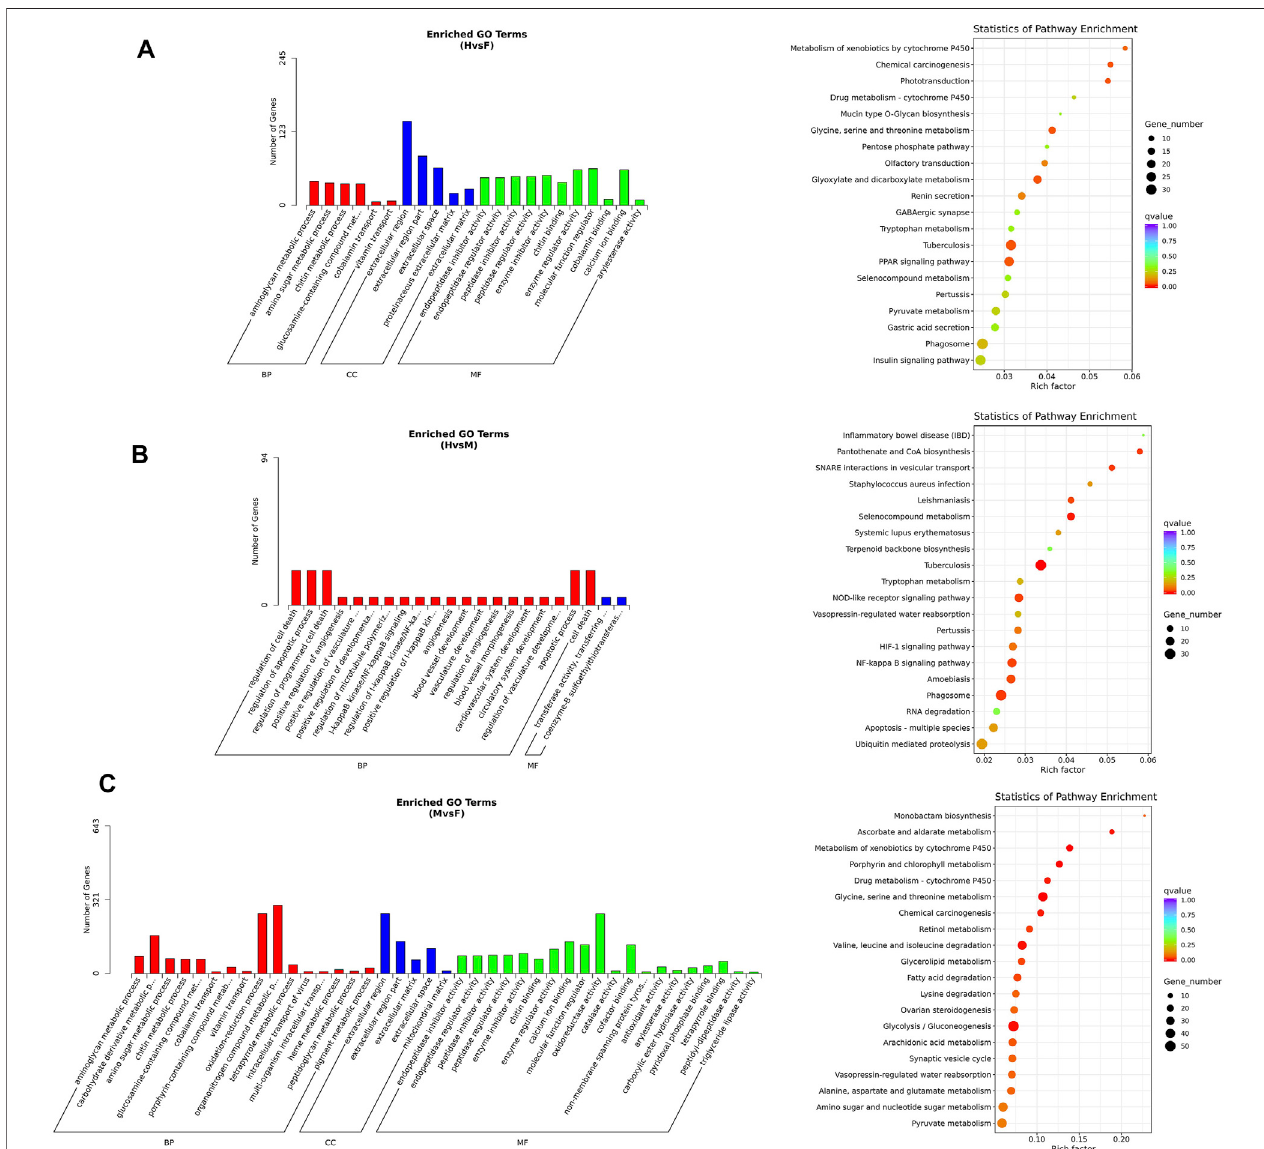
FIGURE6| KEGGandGOenrichmentanalysis (A) GOanalysisand KEGGanalysisofDEGsunderhermaphroditeandfemale. (B) GOanalysisandKEGG analysis of DEGs under hermaphrodite and male. (C) GO analysis and KEGG analysis of DEGs under male and female.